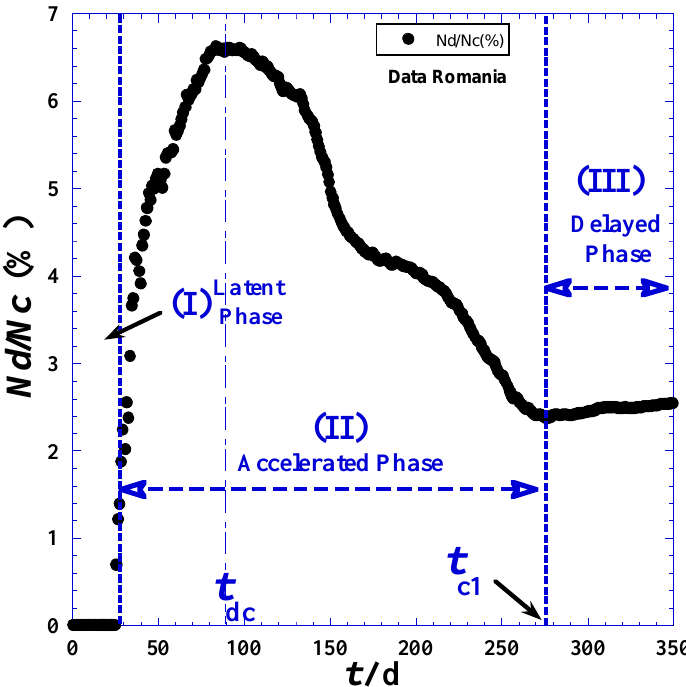
Figure 5. Mortality rate T ( t )as a function of time for the first 350 days of the pandemic in Romania.